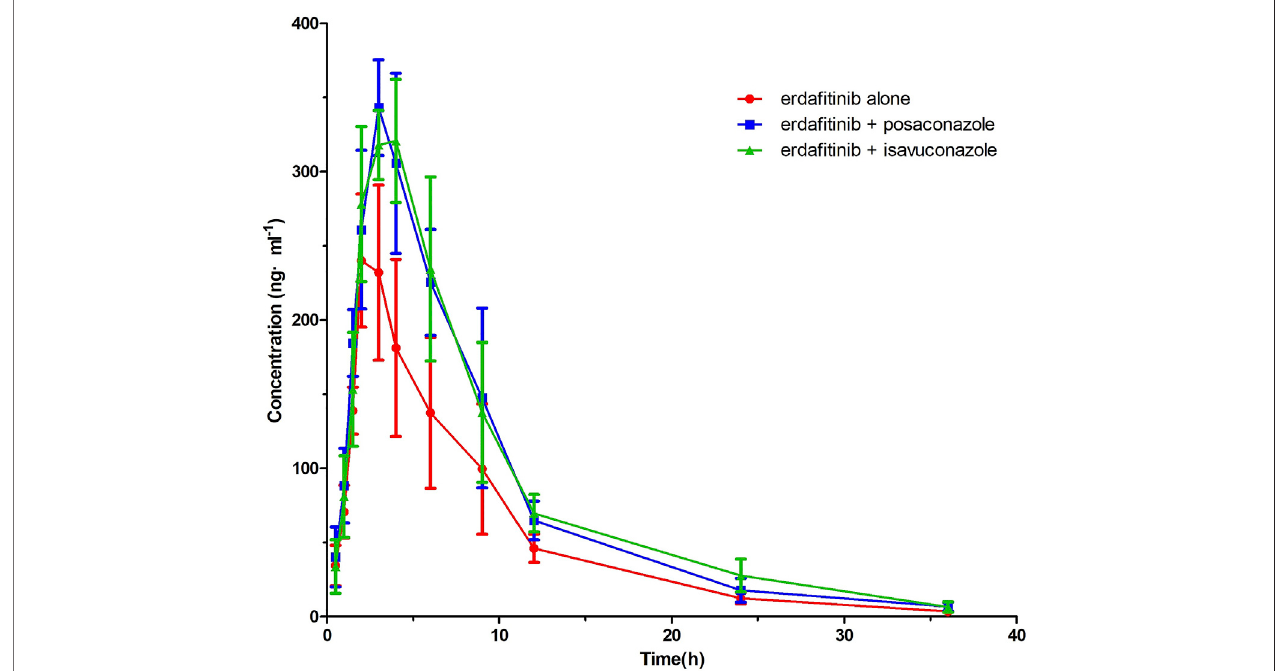
FIGURE 2 | Mean plasma concentration – time pro fi le of erda fi tinib after administration to six beagle dogs dosed alone and incombination with posaconazole or isavuconazole.